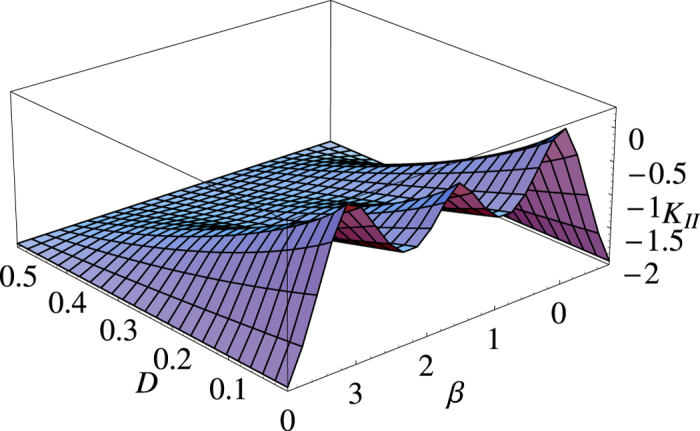
Key rate, KII for varying β and D.